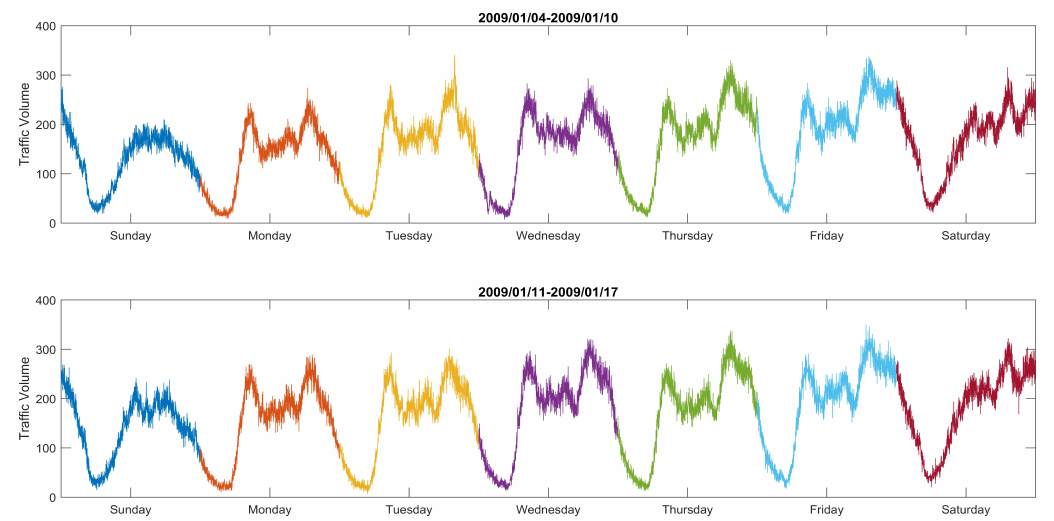
Figure 3. Daily statistics of taxis on demand in New York City.